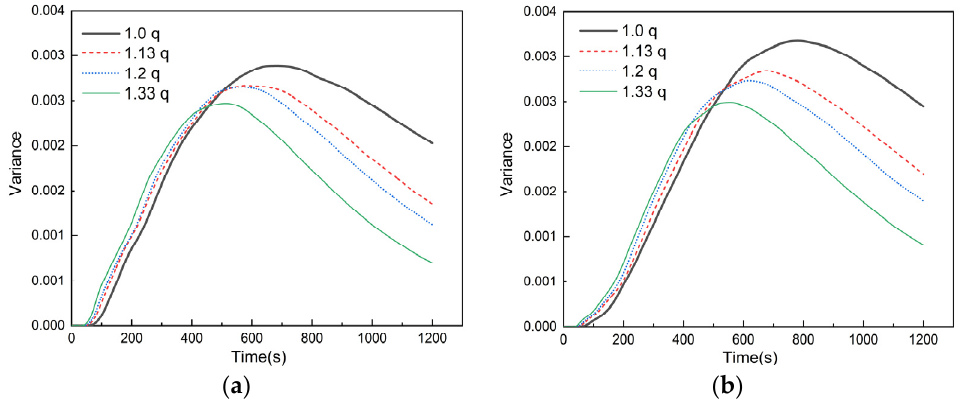
Figure 16. Variance of outflow percentage of the double-weir tundish with uniform increasing casting flow rate under single-strand blockage conditions: ( a ) strand 1 blockage, ( b ) strand 2 blockage. From the time average variance result (Table 4), it can be seen that the consistency of each strand increases with the increase of the flow rate of the outlet. When the flow rate of the outlet is 1.33 q, the consistency of each strand is the best among the studied cases. Compared with the 1.0 q result, the average variance of the 1.33 q case is reduced by 25.25% and 27.27% for strand 1 blockage and strand 2 blockage conditions, respectively. Table 4. Time average variance of outflow percentage of each strand with uniform increasing casting flow rate under single-strand blockage conditions of two tundish designs.